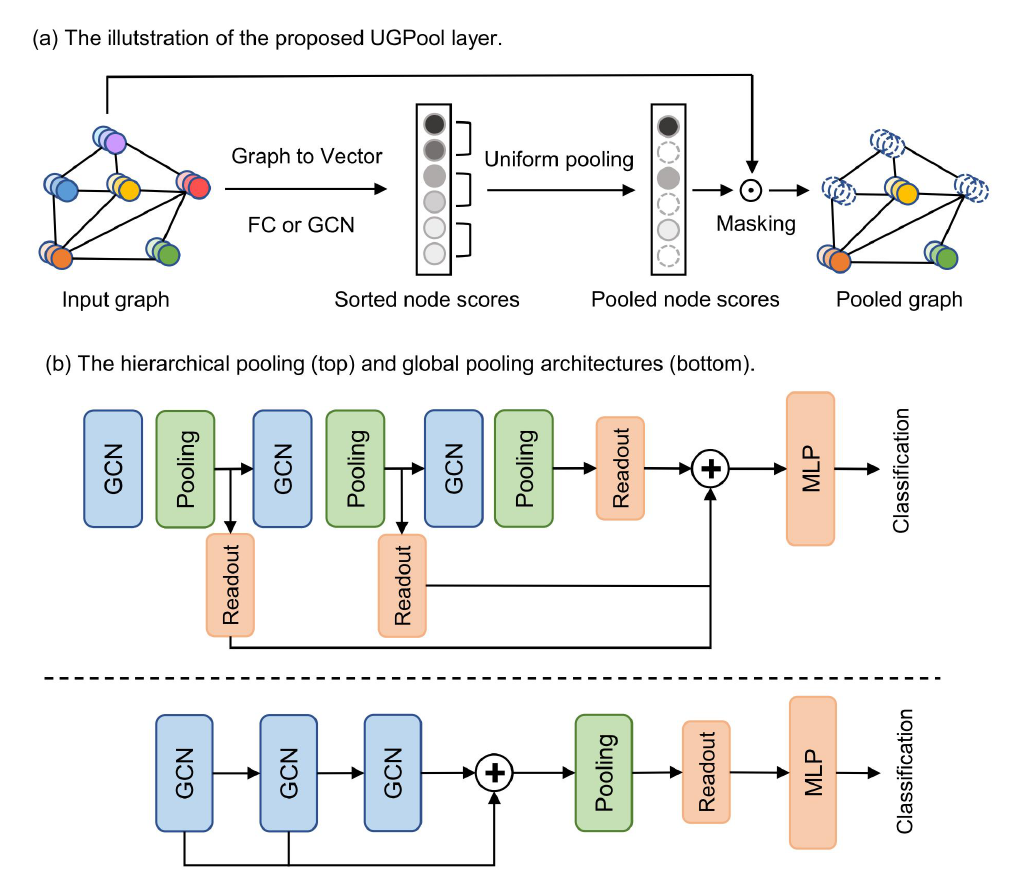
Figure 1. An illustration of the UGPool layer, and hierachical pooling and global pooling